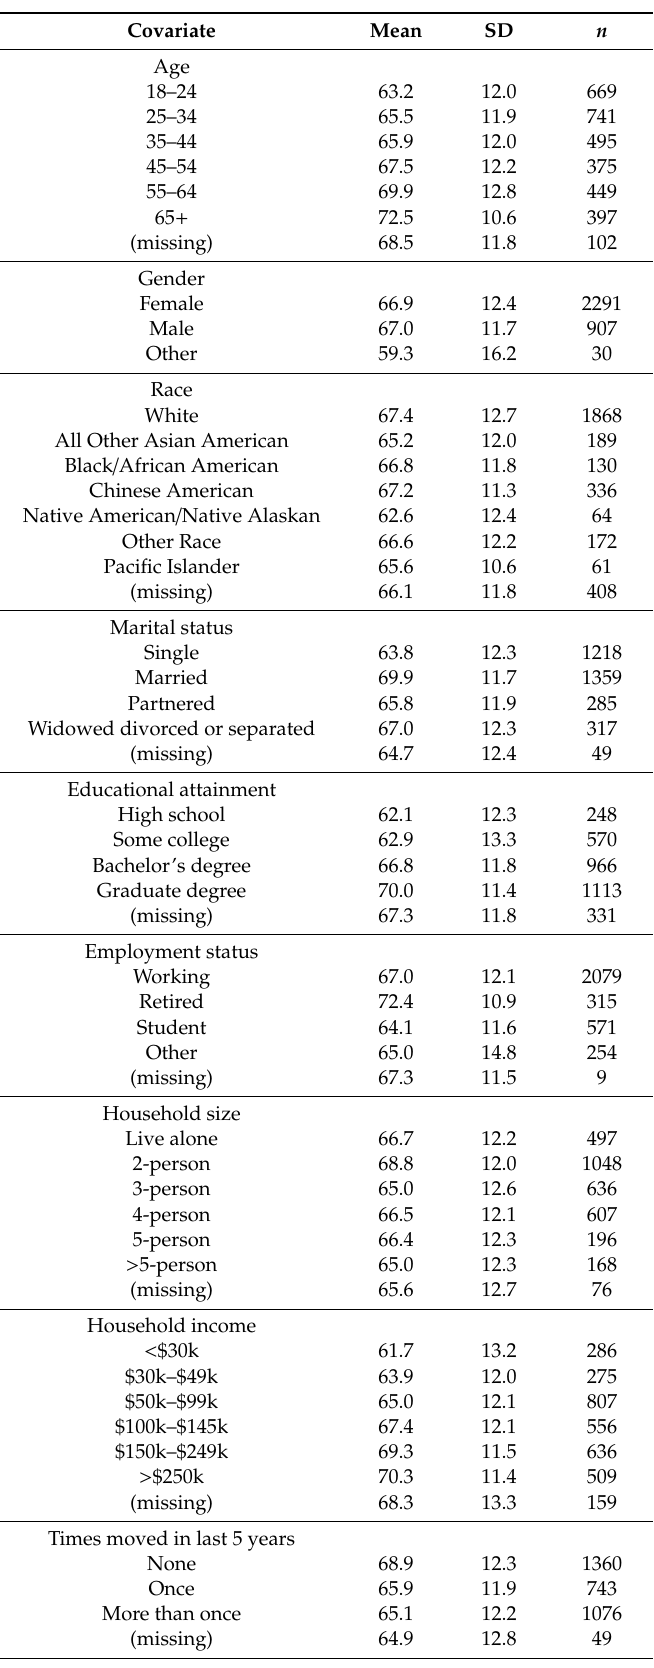
Table 2. Stanford well for life participant characteristics and overall well-being score